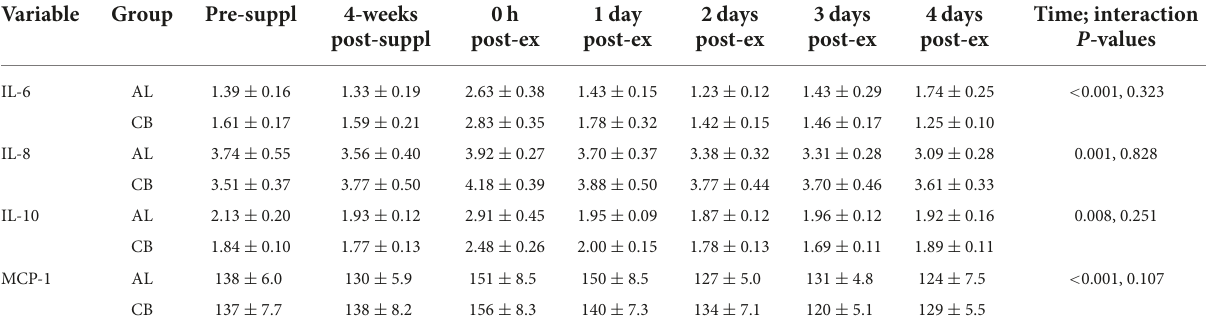
TABLE 5 Plasma cytokine data before and after 4-weeks supplementation, and immediately post 90 min eccentric exercise and in an overnight fasted state during 4 days of recovery (AL = almond, n = 33; CB = cereal bar, n = 31) (means ± SE). Variable